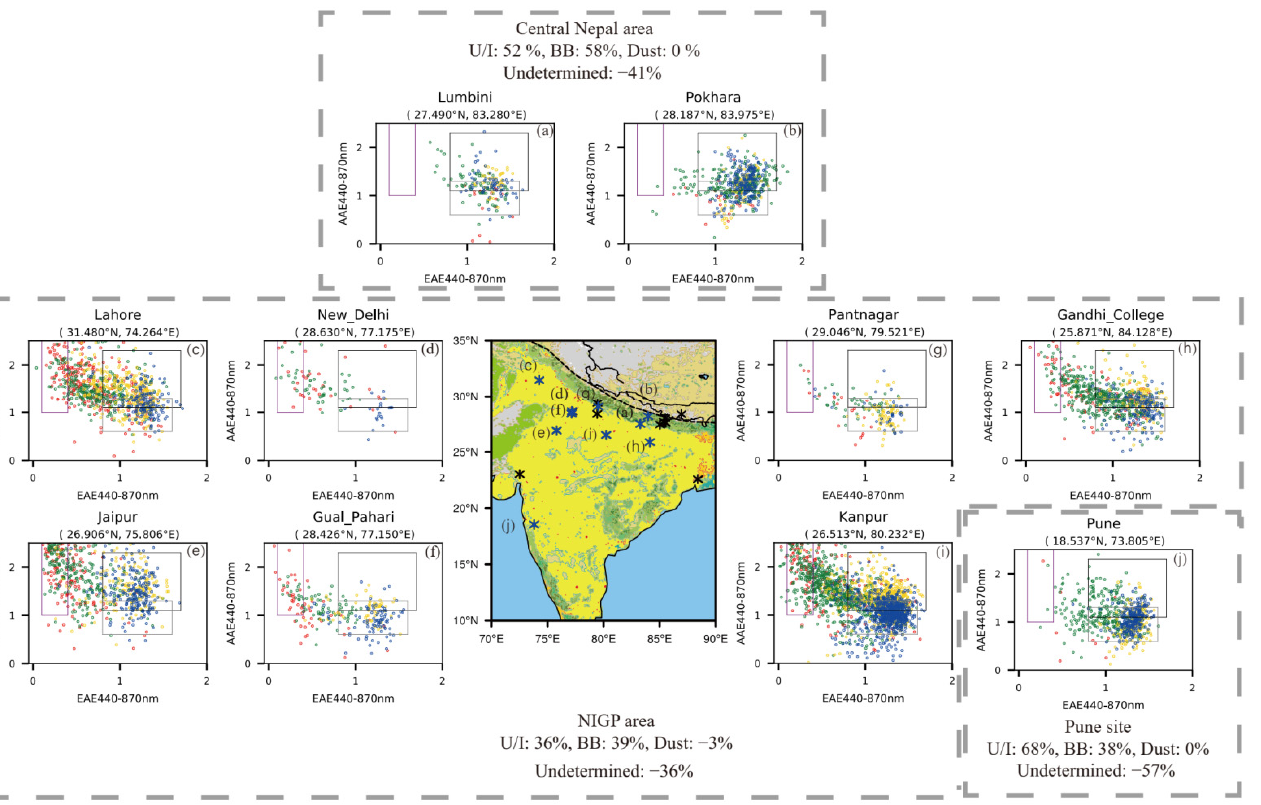
Figure 6. The aerosol types at the AERONET sites ( a – j ) near India identified by the 2 ‐ D clustering method using AAE and EAE for the period of March 1998 to February 2018. The blue asterisks on the map indicate the locations of the sites with enough valid data for analysis, while the black ones represent the sites that are not used. The green, red, yellow, and blue dots on the scatter plots represent the data in boreal spring (March, April, and May), summer (June, July, and August), autumn (September, October, and November), and winter (December, January, and February), respectively. The boxes plotted with dashed lines indicate the sub ‐ regions listed in Table 4. For each sub ‐ region, the differences in percentage (2 ‐ D result minus MD result) for the U/I, BB, dust, and undetermined aerosols are shown, respectively.